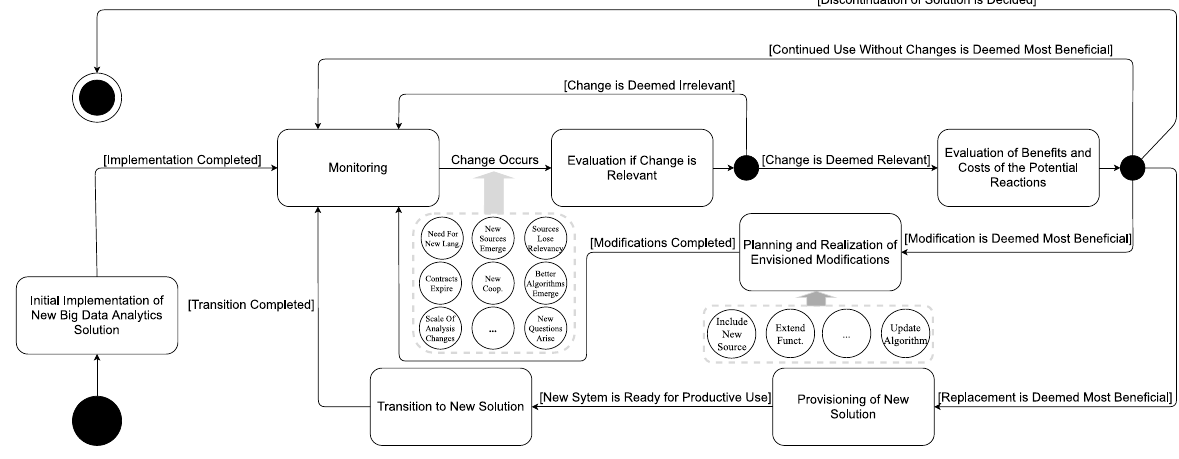
Figure 6. States of a big data analytics solution in a dynamic business